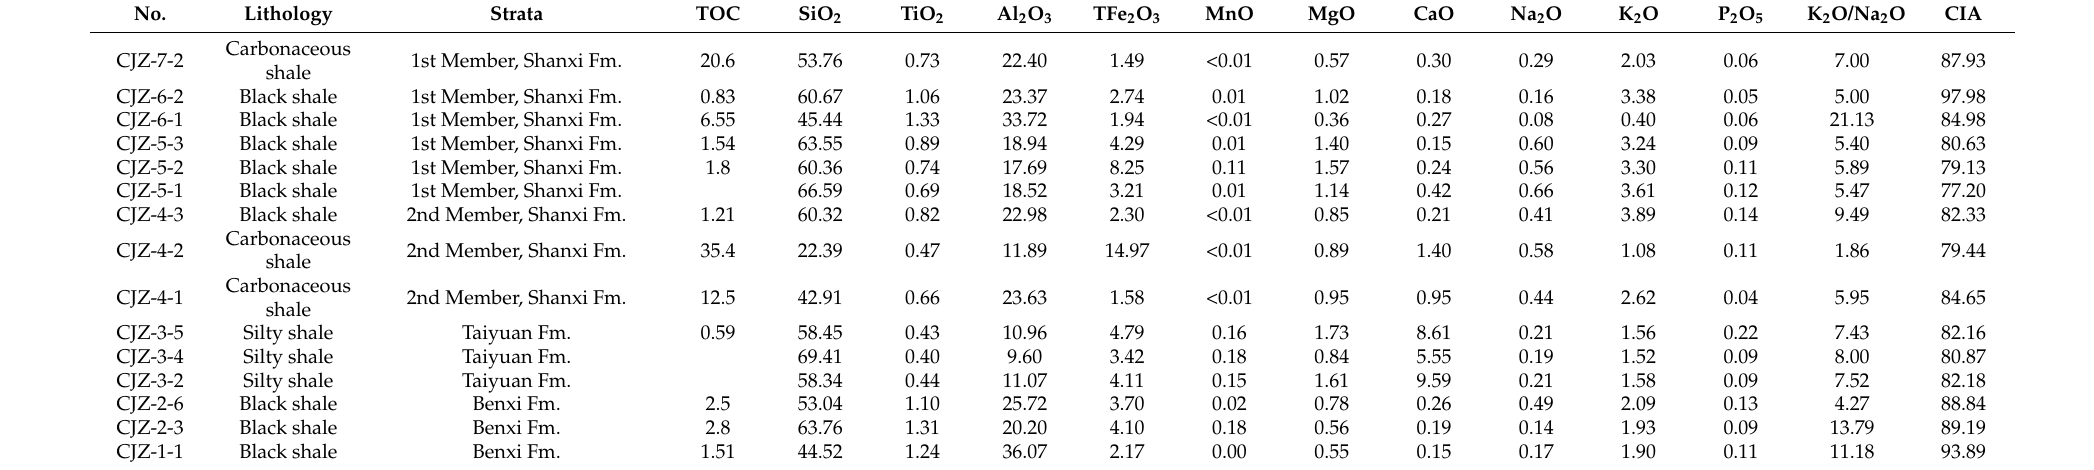
Table 1. TOC and major element compositions of Benxi − Shanxi Formations in the Liulin